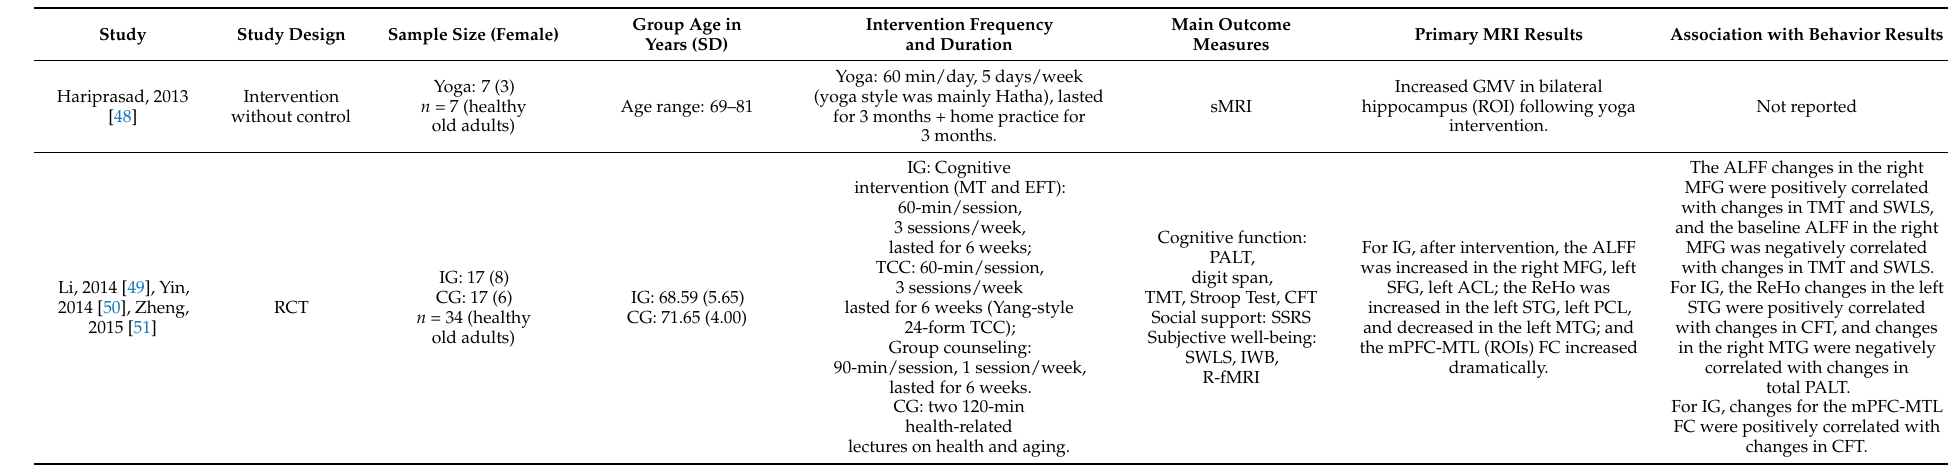
Table 2. Summary of included intervention